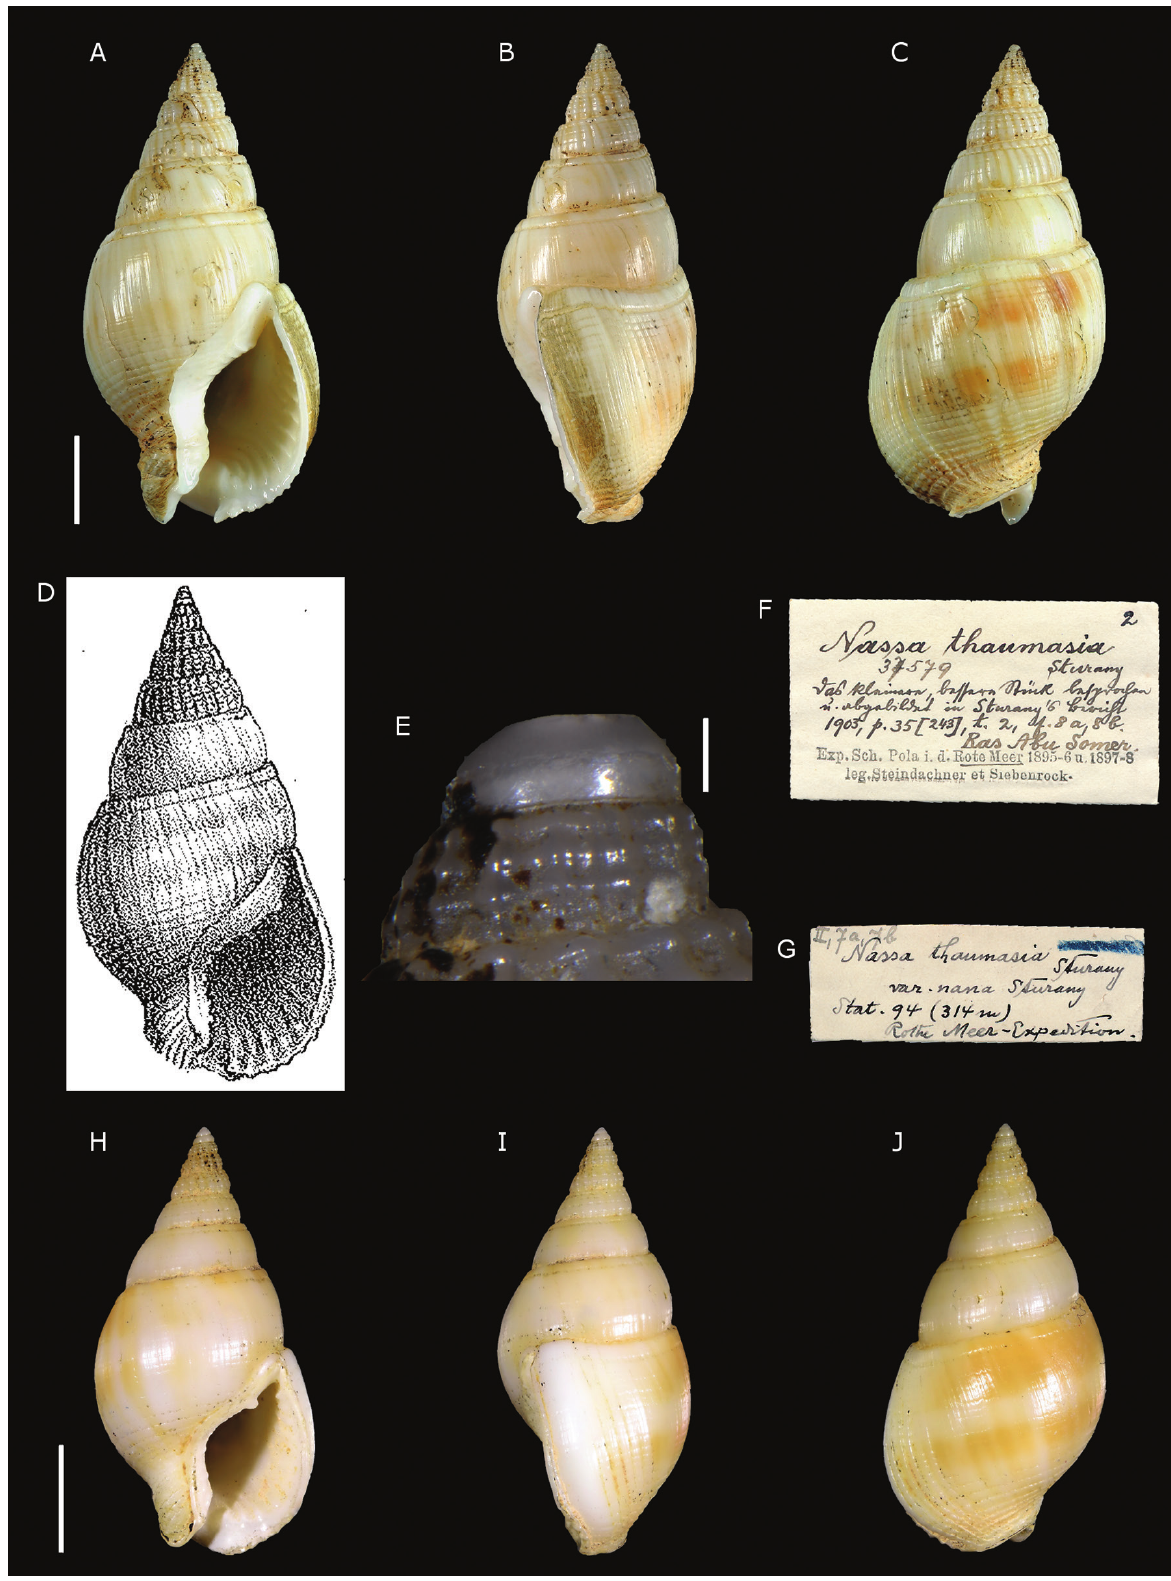
Figure 17. Nassa thaumasia Sturany, 1900. A–C, E . Lectotype, NHMW 37579, Ras Abu Somer, Egypt, Red Sea (likely “locality 18”): front ( A ), right side ( B ), back ( C ), protoconch ( E ). D . Original figure by Sturany (1903). F . Original lectotype label. G . Ori ginal label of the form nana . H–J . Form nana , syntype NHMW 84181, Station 94 (Nuweiba, Gulf of Aqaba, Egypt): front ( H ), right side ( I ), back ( J ). Scale bars: A–C, H–J : 5 mm, E : 0.2